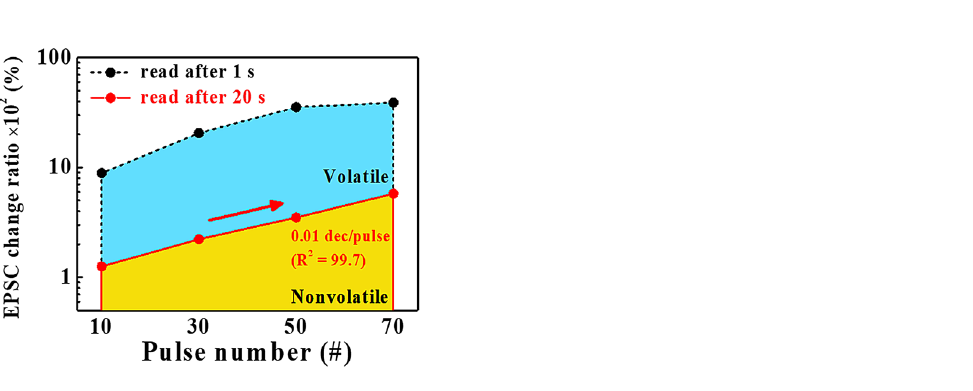
Figure 8. Dependence of the EPSC change ratio, (( I – I 0 )/ I 0 × 100%), according to the pulse spike numbers. I 0 is the resting current and I is the EPSC in the channel after the pre-synaptic